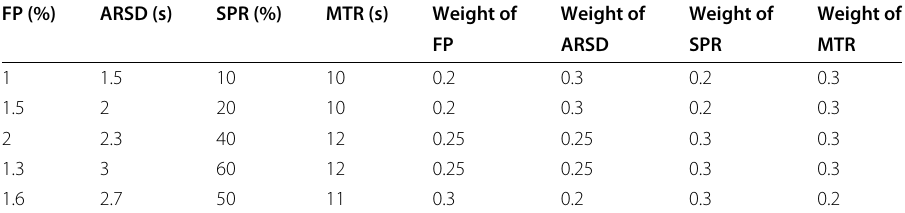
Table 2 The QoS parameters and their